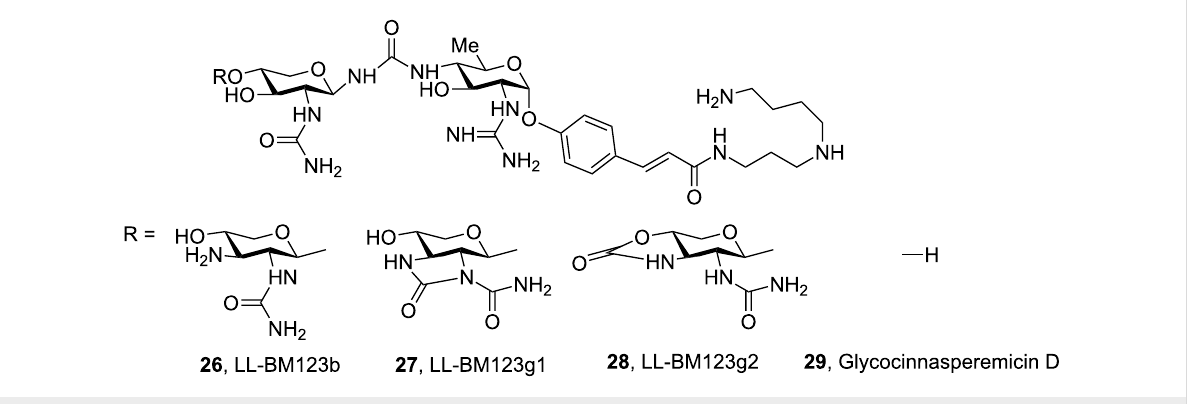
Figure 13: Aminoglycosidic antibiotics of the glycocinnamoylspermidine family.